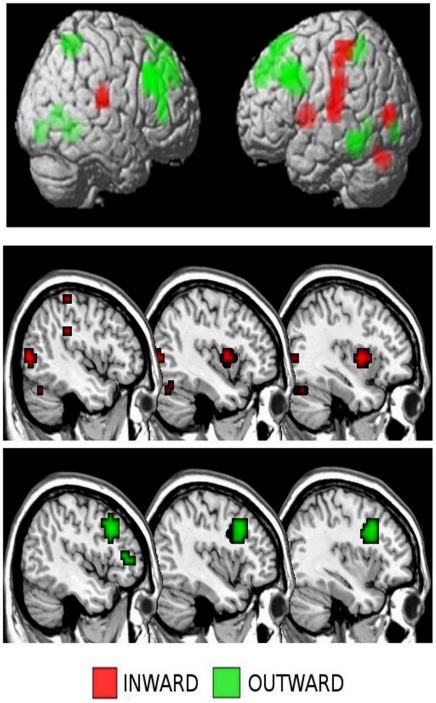
3D rendering (image threshold at p<0.05 FWE corrected) of the BOLD response of the main effects of group factor.Significant activation: INWARD: left posterior insula BA13, and the right parietal lobe SII BA40; OUTWARD: bilateral DLPFC BA9, bilateral precuneus BA7. 2-D overlay with multiple slices of insular activation in each group.